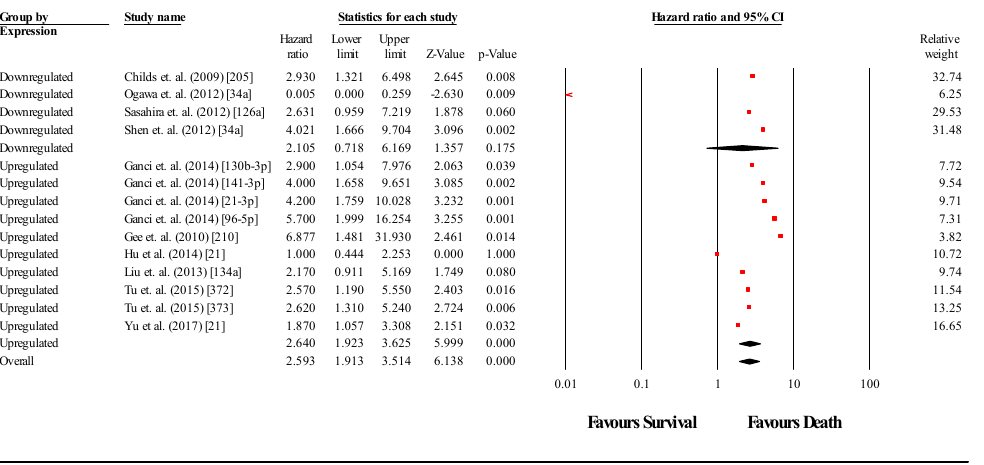
Figure 3. Forest plot for the miRNAs associated with DFS.